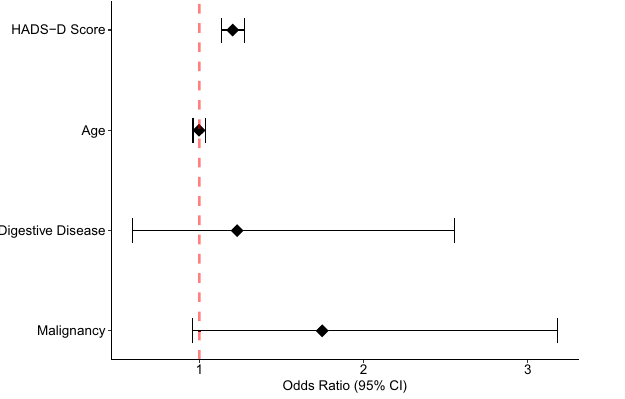
Figure 2. The results of multilevel generalized linear model with binomial family and logit link. Forest plot of odds ratio and 95% confidence intervals for adjusted variables. HADS-D shows the odds ratio for each one- point change in the score. Similarly, the odds ratio for a 1-year change in age is shown. HADS-D, Hospital Anxiety and Depression Scale–Depression.